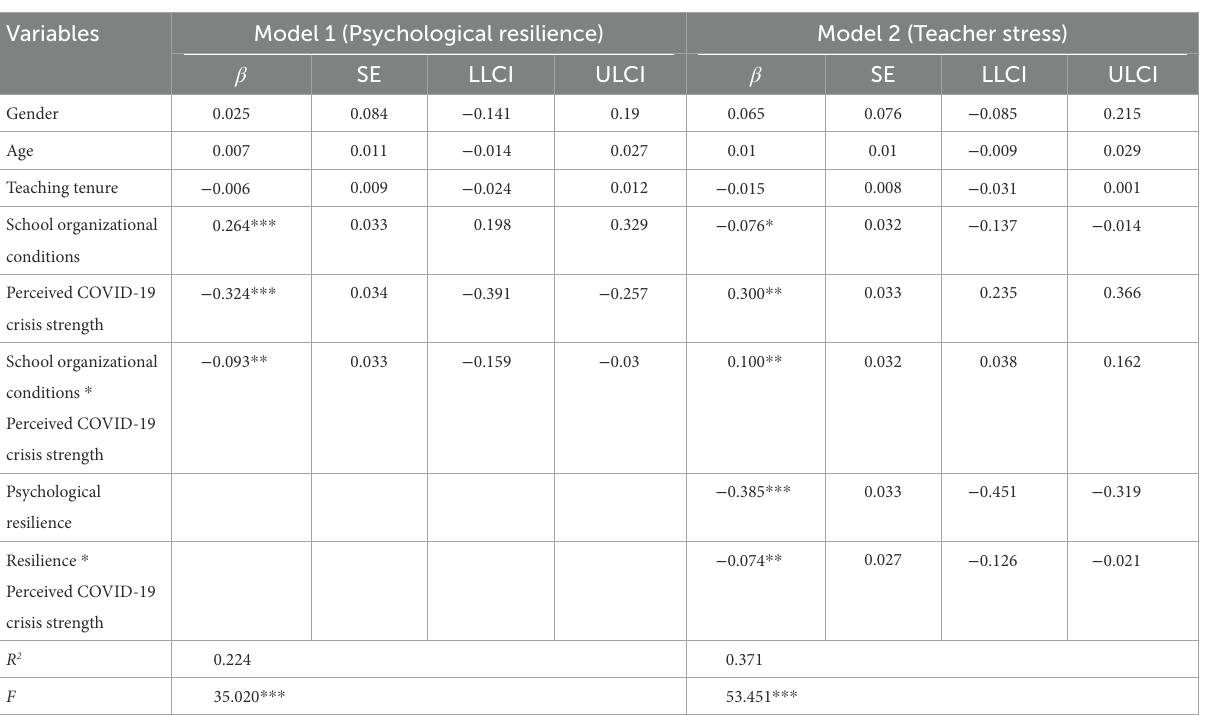
TABLE 3 The moderated mediation effect of school organizational conditions on teacher